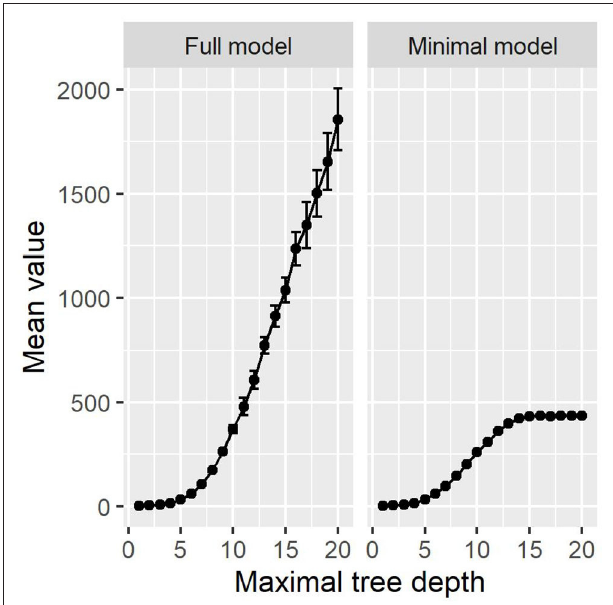
FIGURE 8 | The number of leaves in the Decision Tree models. The full model increases exponentially. The minimal model’s size is constant above a depth of around